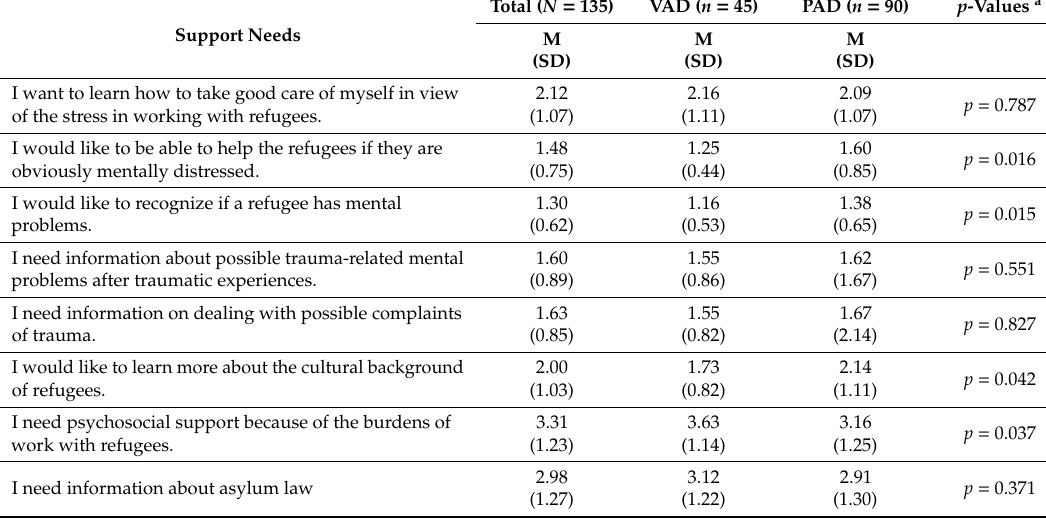
Table 3. Information on support needs of the total study sample, VAD and